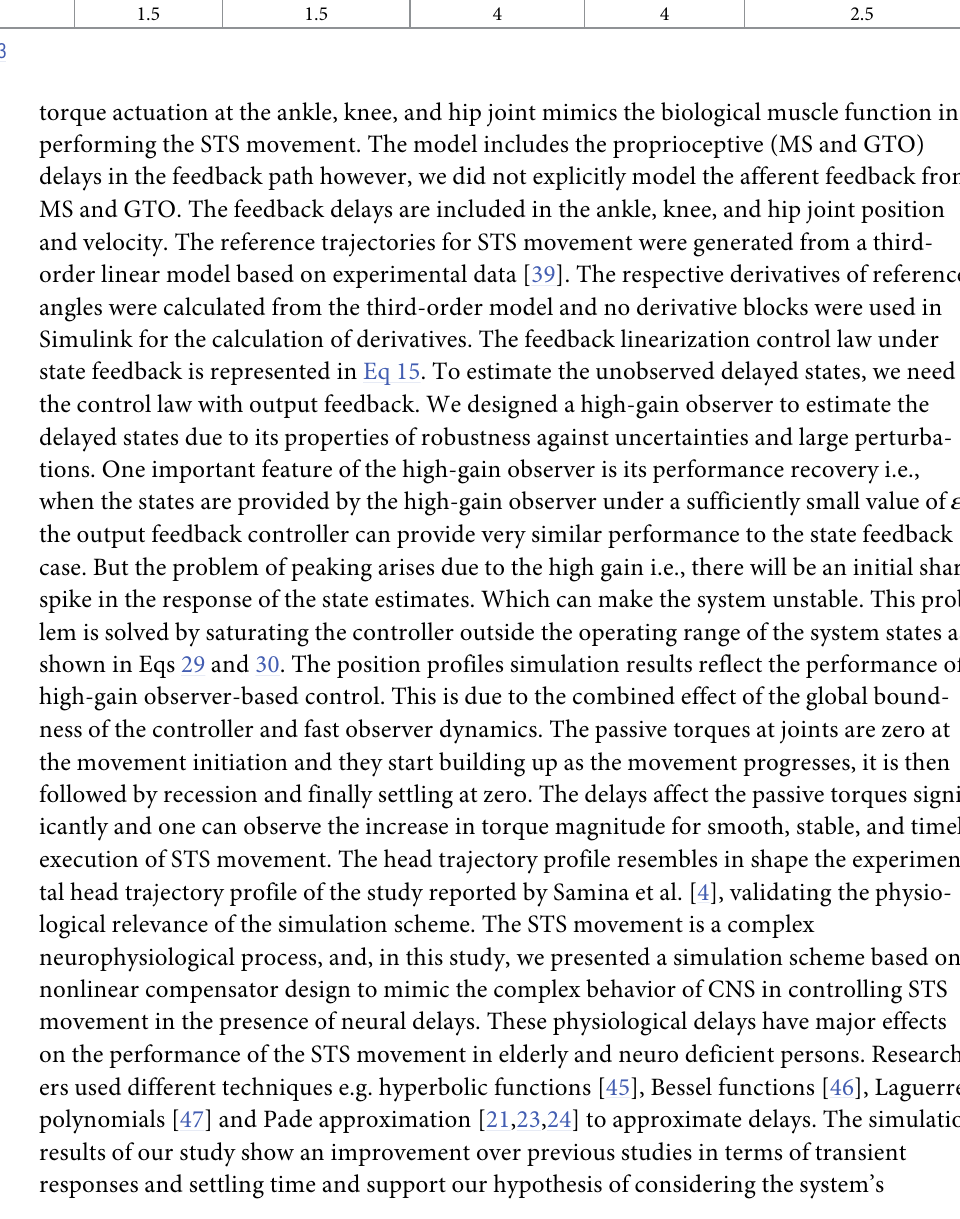
Hip movement in opposite direction (beyond 1.57